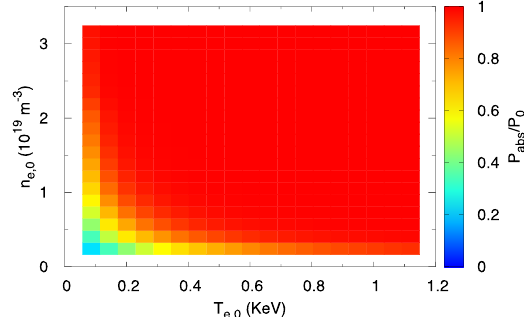
Fig. 9. Absorbed power fraction as a function of T e,0 and n e,0 for TOP mirror; similar results are found for MID and